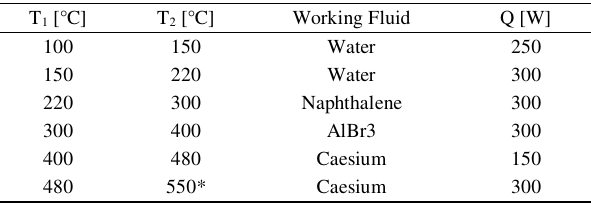
Table 2. Transferred heat power depending of the working fluid and operating temperature range accepted for the